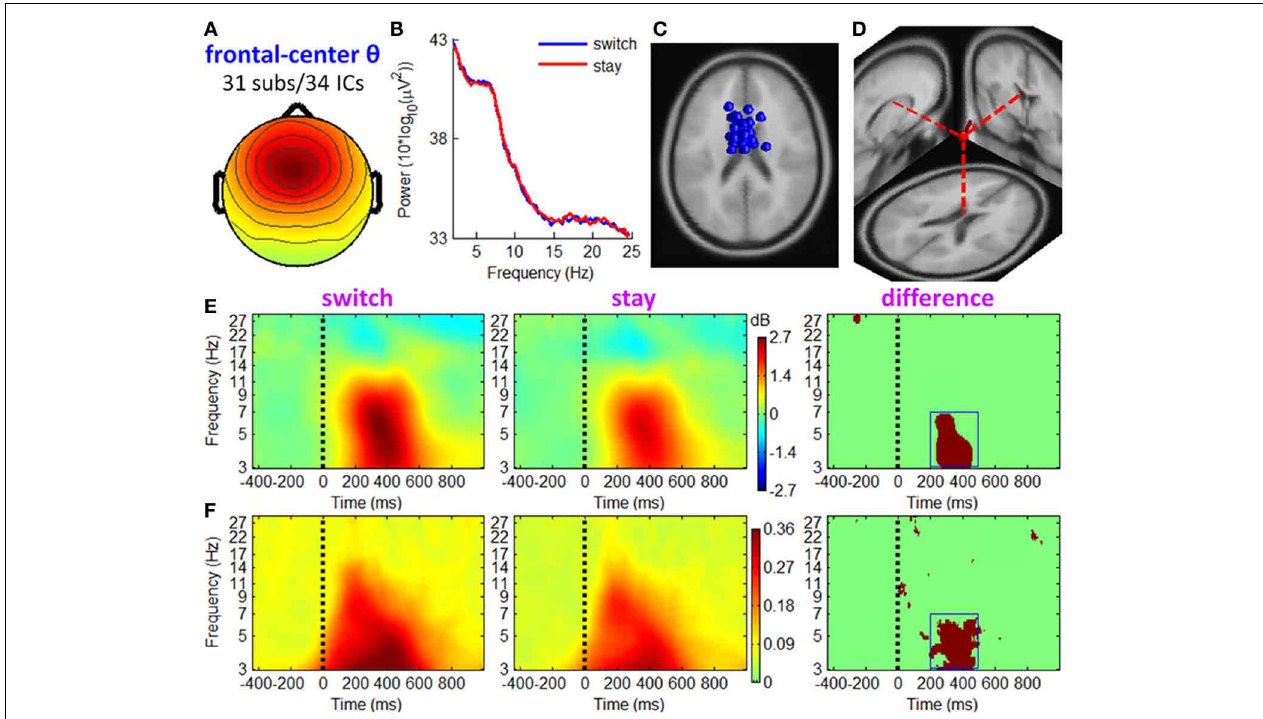
FIGURE 6 | IC properties of fronto-central theta cluster. (A) Mean scalp maps across 34 ICs. (B) Mean power spectra. (C) Equivalent dipole locations of 34 ICs. (D) Mean dipole location and orientation, projected into a standard brain. (E) Mean ERSP image. Colors show significant deviations in log power (dB) from baseline; green indicates no significance